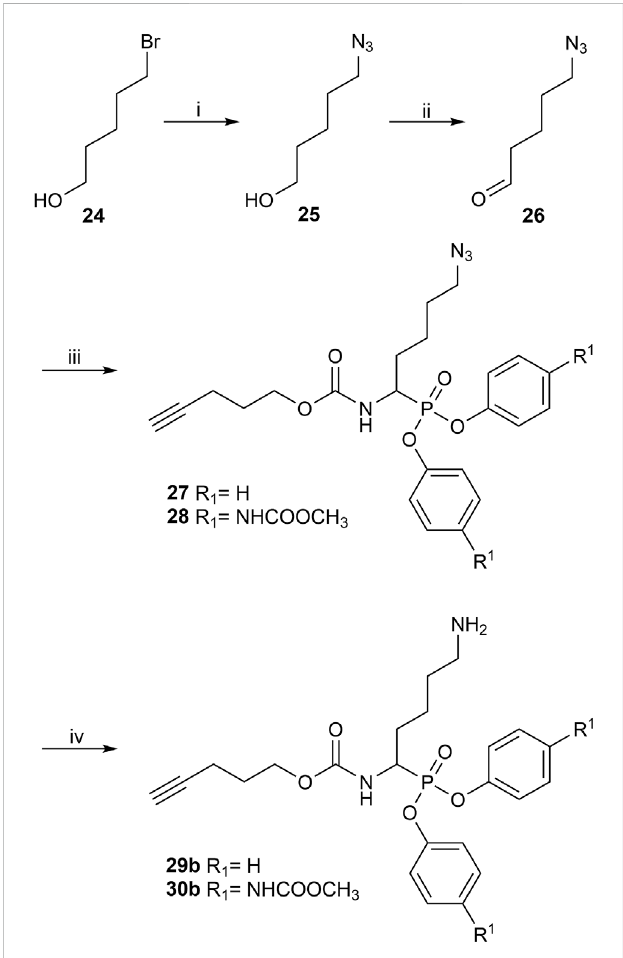
Synthesis of alkyne probes with Lysine as selectivity enhancing moiety (i) NaN 3 , H 2 O, 80 ° C, 18 h; (ii) DMP, DCM, 0 ° C to rt, 4 h; (iii) phosphite 9 or 10, carbamate 8, Lewis acid, DCM, rt, 16 h; (iv) Polymer supported triphenylphosphine, THF, rt, 72 h.